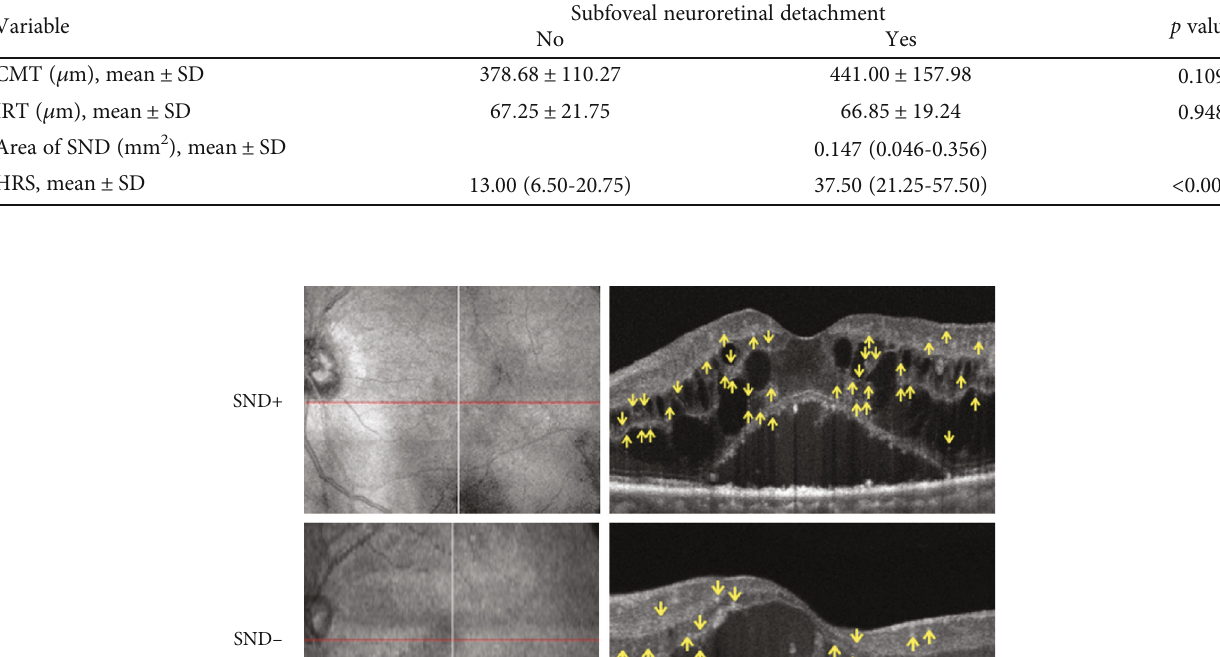
Table 3: Comparisons of the morphologic measurements between the eyes with and without subfoveal neuroretinal detachment. Variable